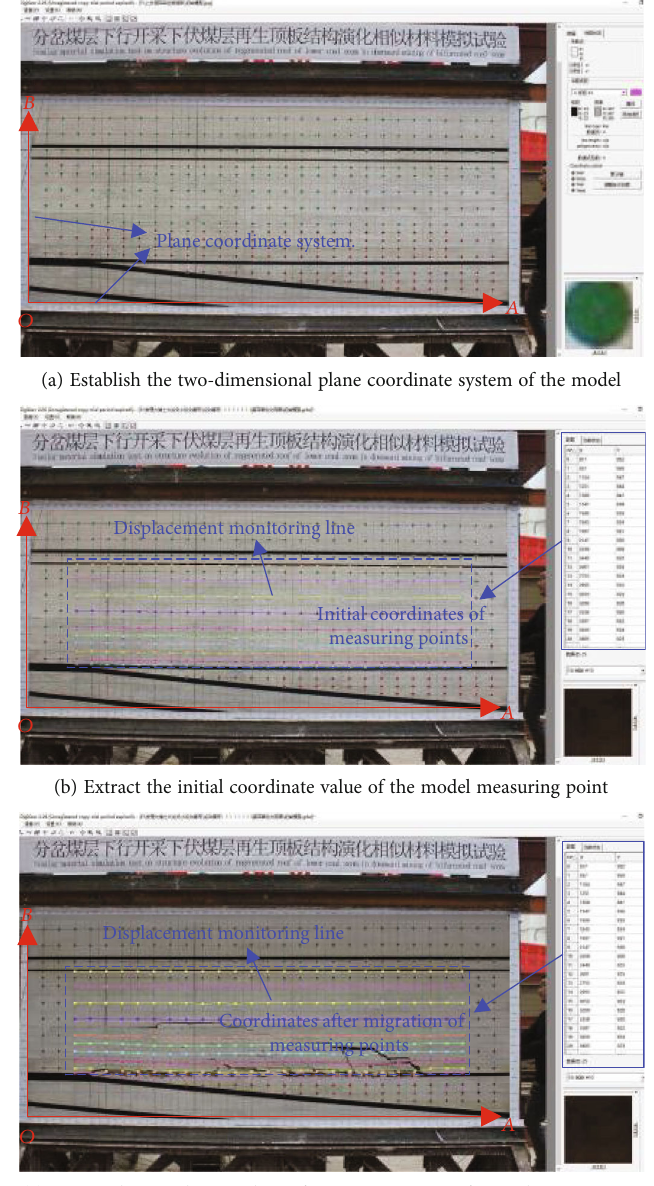
Figure 4: Schematic diagram of measuring point displacement data